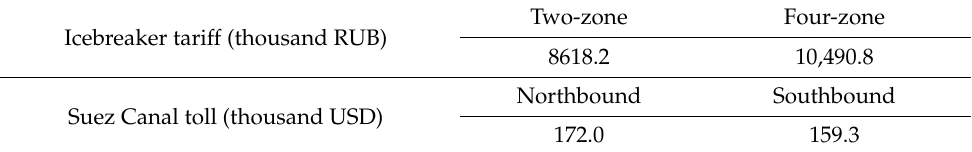
Table 9. Toll and Tariff per